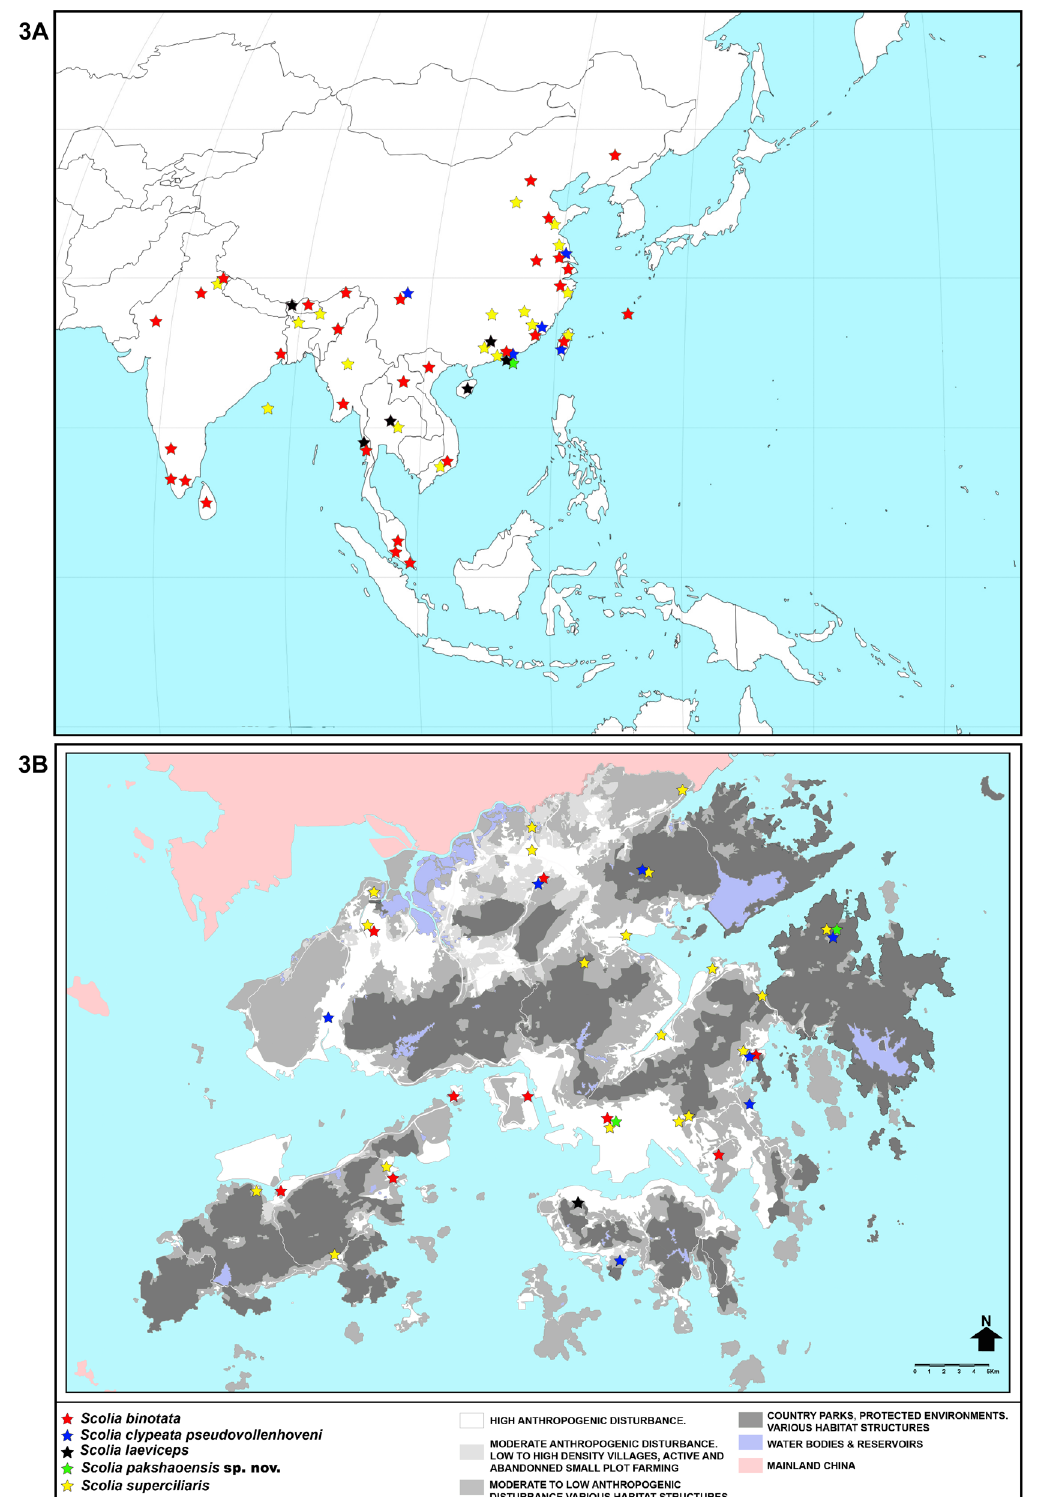
Fig. 3. Distribution of five species of Scolia Fabricius, 1775: Sc. binotata Fabricius, 1804, Sc.